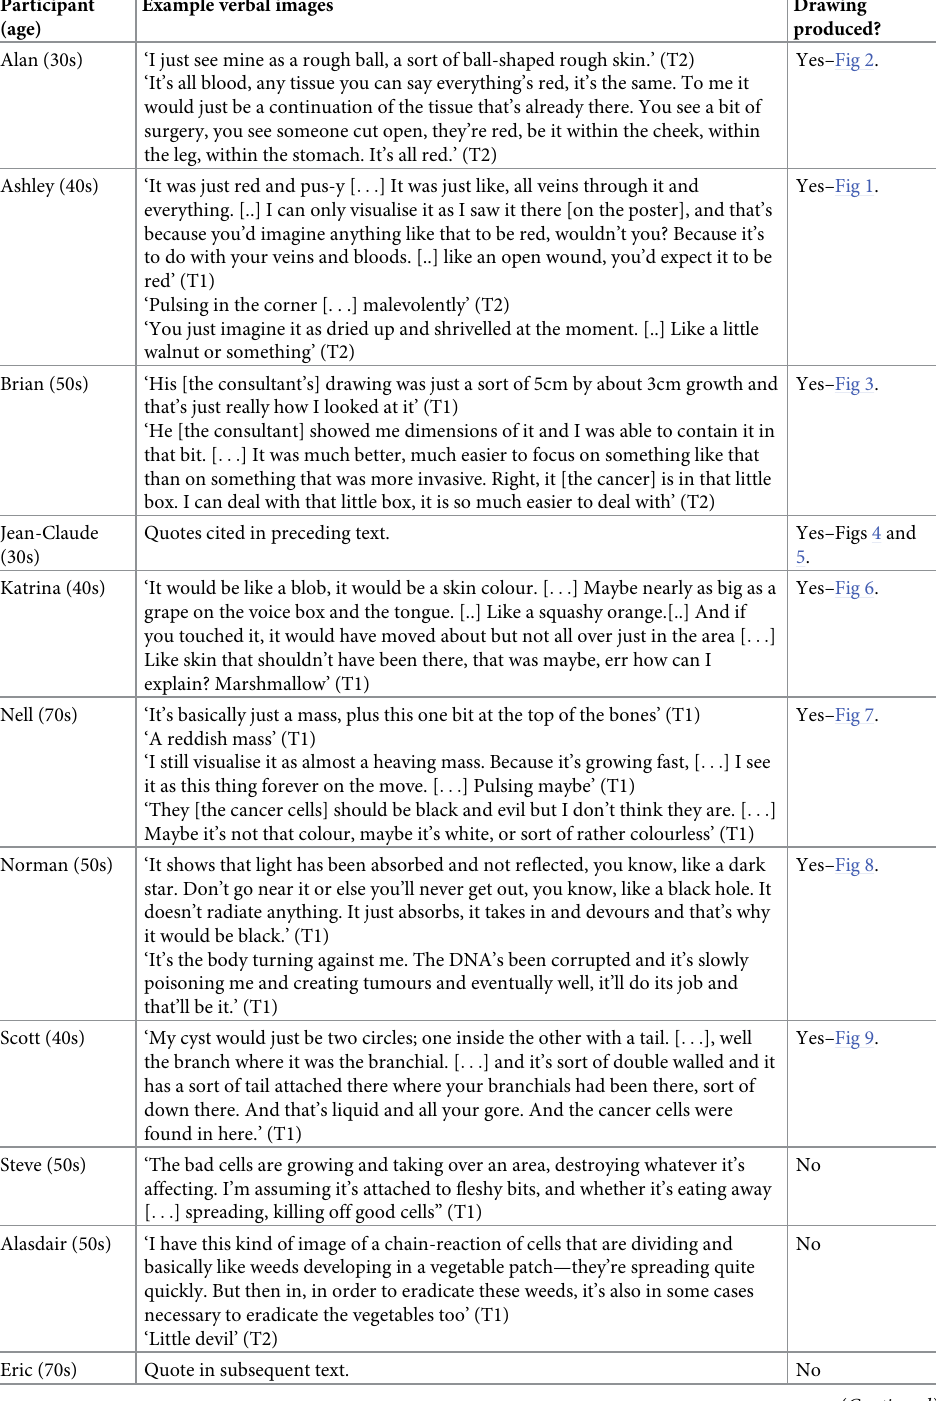
Table 2. Participants’ verbally conveyed mental